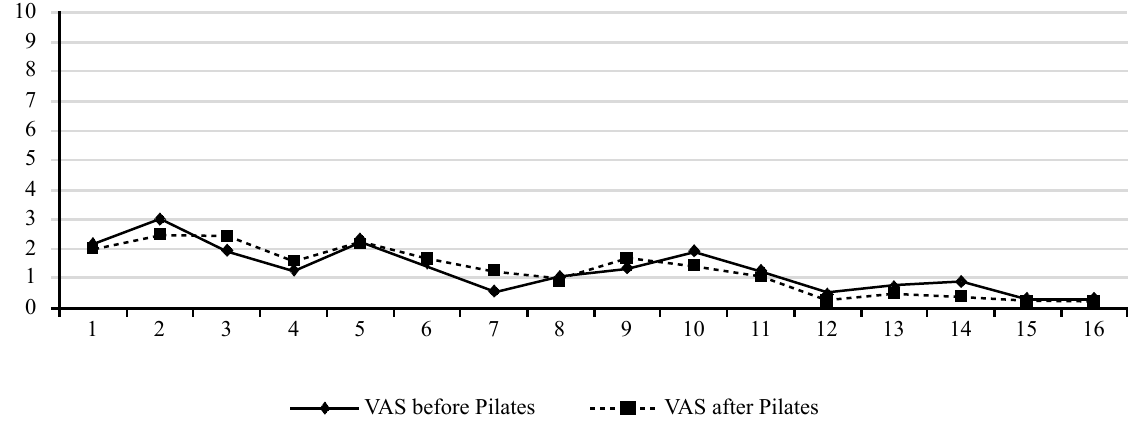
Figure 3. Evolution of pain at visual analogue scale (VAS) throughout the 16 days of